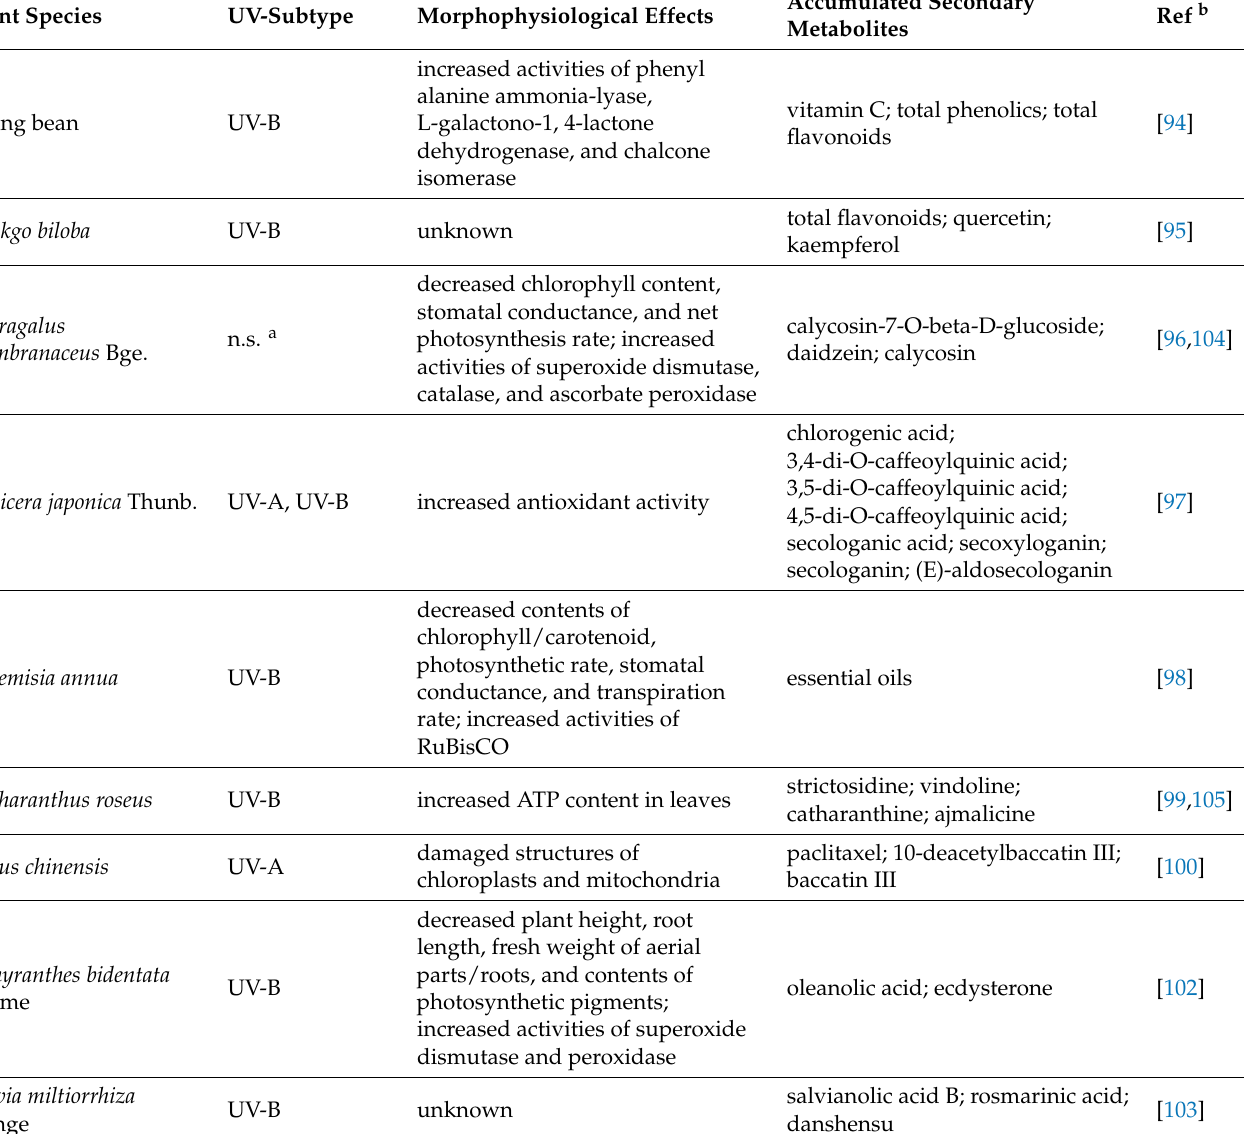
Table 3. Morphophysiological effects and accumulation of secondary metabolites in plants under ultraviolet irradiation. Plant